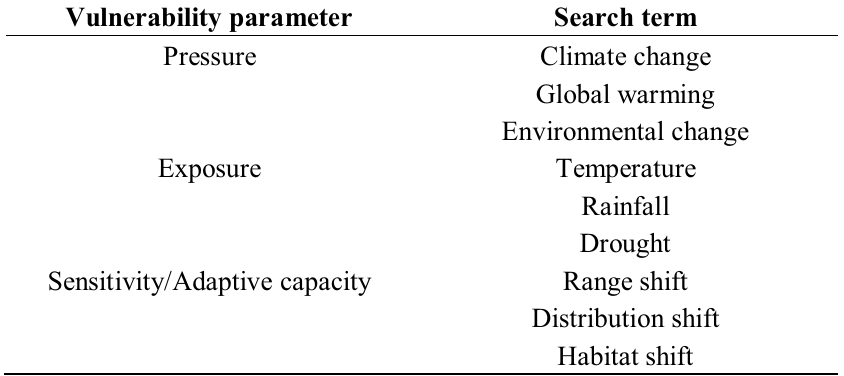
Table 2. Search terms used in conjunction with the species (cid:182)(cid:3) name for the literature